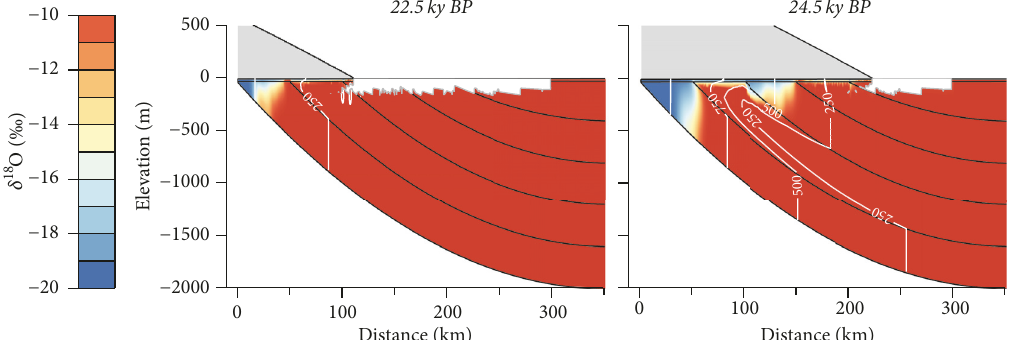
Figure 8: Evolution of hydraulic heads and 𝛿 18 O during the simulation considering permafrost (E). The white surface represents the permafrost layer. White lines are hydraulic head